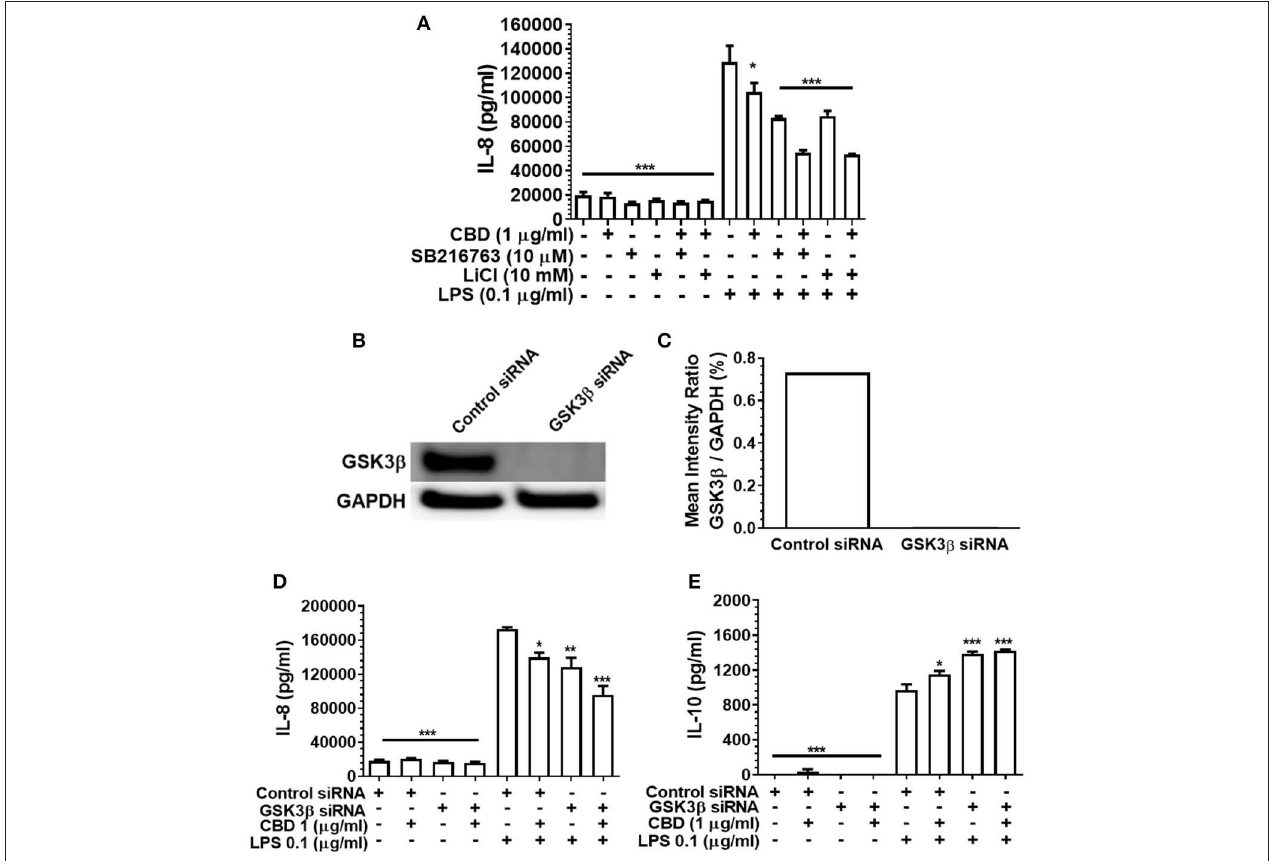
FIGURE 6 | Phytocannabinoid diversion of the innate response to oral bacteria is not GSK3 β -dependent. IL-8 concentrations in 20h cell-free supernatants were collected from primary human monocytes stimulated, or not, with LPS (0.1 µ g/ml) in the presence or absence of CBD, with and without GSK3 β blockade by SB216763 or by LiCl (A,D) . The respective suppressive and enhancing influence of GSK3 β silencing on LPS- and/or CBD-exposed monocyte release of IL-8 (D) and IL-10 (E) are also presented. Efficient GSK3 β knockdown of CB2 was confirmed using Image J software (B,C) . Data represent the mean ± SD of three biological replicates. * / ** / *** p ≤ 0.5/0.01/0.001, compared to control siRNA, LPS-stimulated